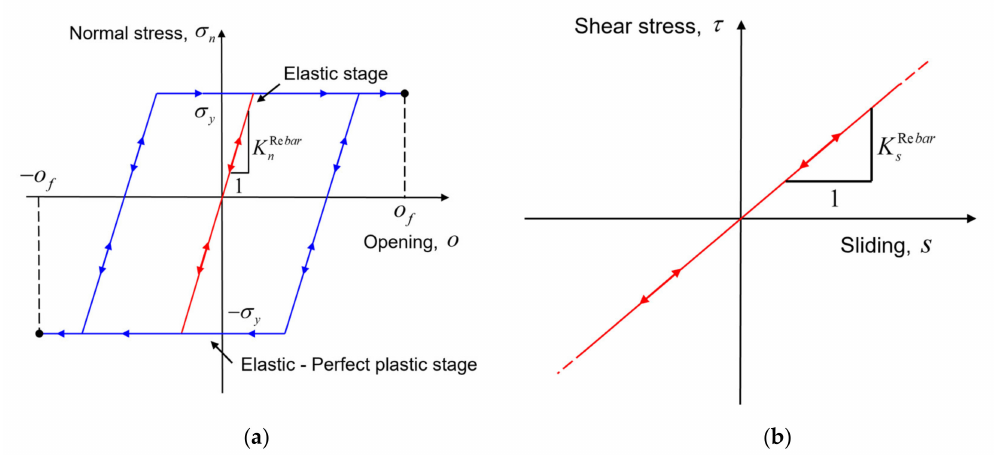
Figure 5. RJE constitutive model in ( a ) axial and ( b ) tangential directions (arrows indicate loading, unloading and reloading